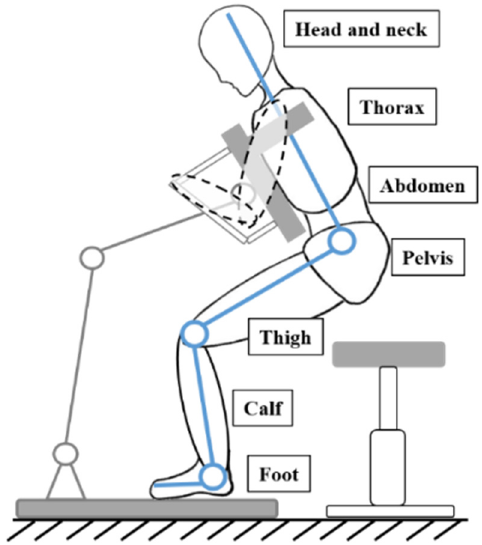
Figure 4. The human-robot mechanics model.